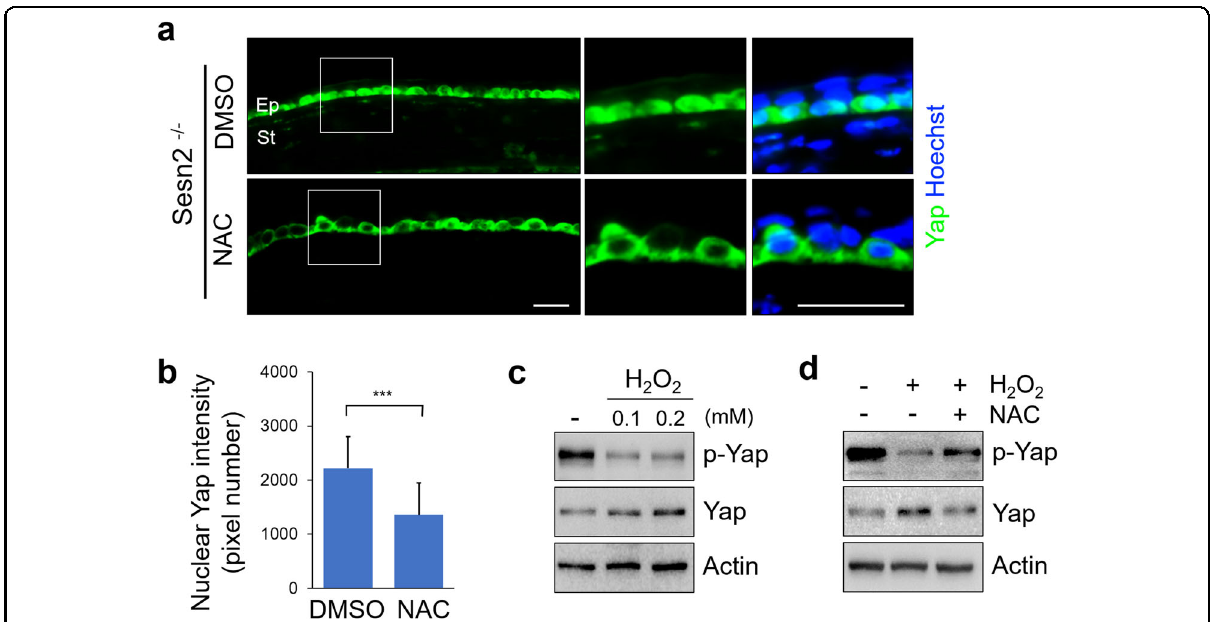
Fig. 6 YAP is activated by increased ROS production. a Sections of injured corneas from Sesn2 − / − mice treated with 2 mM NAC or DMSO were immunostained using an anti-YAP antibody. Treatment with NAC decreased YAP nuclear localization. b Fluorescence intensity of nuclear YAP in corneal epithelial cells treated with NAC or DMSO. The nuclear YAP fl uorescence intensity of NAC-treated corneal epithelial cells was signi fi cantly lower than that of DMSO-treated cells. c Treatment with H 2 O 2 increased YAP activity. hCET cells were treated with 0.1 or 0.2 mM H 2 O 2 for 2 h. Cell lysates were subjected to western blotting with phospho-YAP, YAP, and actin antibodies. d Treatment with NAC suppressed YAP activity. hCET cells were treated with 0.2 mM H 2 O 2 or 2 mM NAC and subjected to western blotting with phospho-YAP, YAP, and actin antibodies. Error bars represent the means ± SD of three independent experiments. Two-tailed Student ’ s t -test (*** p < 0.001). Scale bar, 50